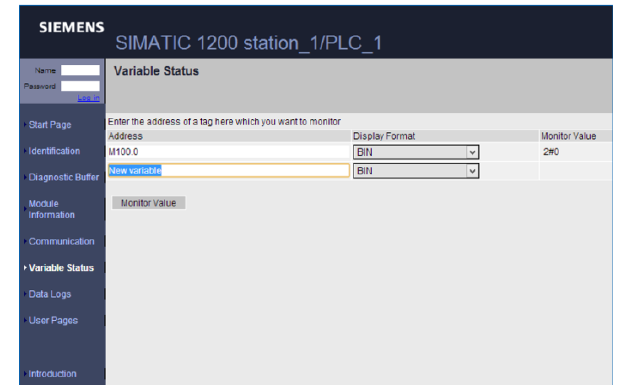
Figure 1. Standard web interface of